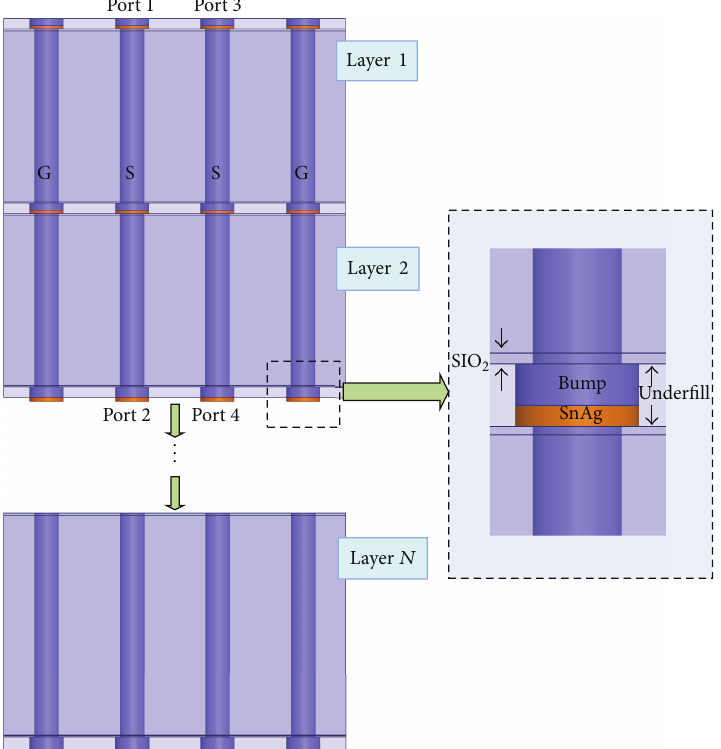
Figure 6: Multilayer TSV structure (parameters of the structure: thickness of the SnAg is 2 𝜇 m, bump height is defined as 𝐻 , 𝐻 = 5𝜇 m, and bump radius is defined as 𝑅 , 𝑅 = 15 𝜇 m, ℎ TSV = 100 𝜇 m, 𝑟 TSV = 10 𝜇 m, 𝑡 = 1 𝜇 m, 𝑡 OX = 0.6 𝜇 m, and 𝑝 TSV = 40𝜇